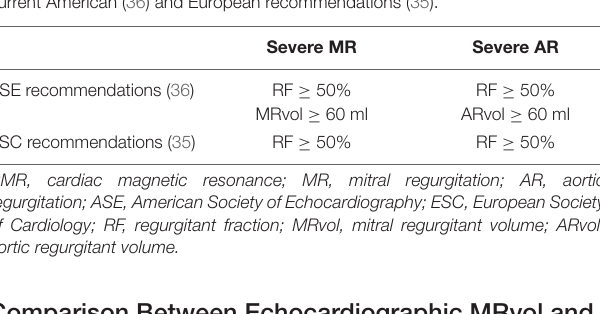
TABLE 3 | Cutoff of CMR parameters to define severe MR and AR according to current American (36) and European recommendations (35).